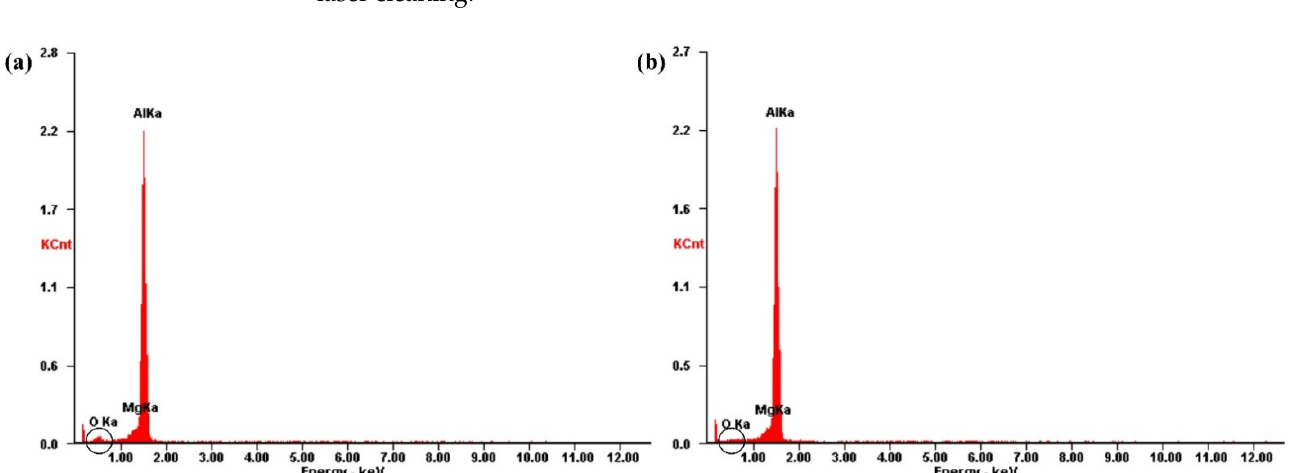
Figure 2. The variation of the surface oxygen content with the process parameters: ( a ) laser power; ( b ) scanning frequency; ( c ) cleaning speed.